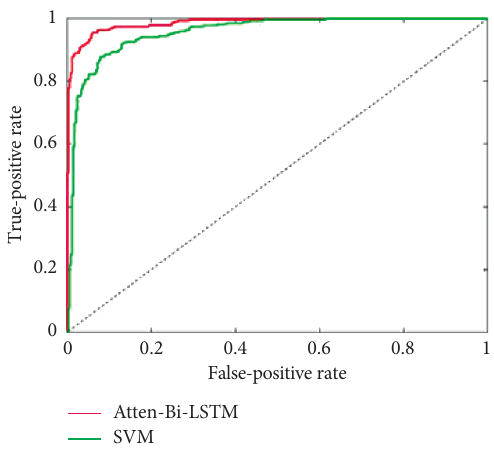
Figure 8: ROC curves of the identification by the two models in the total event.